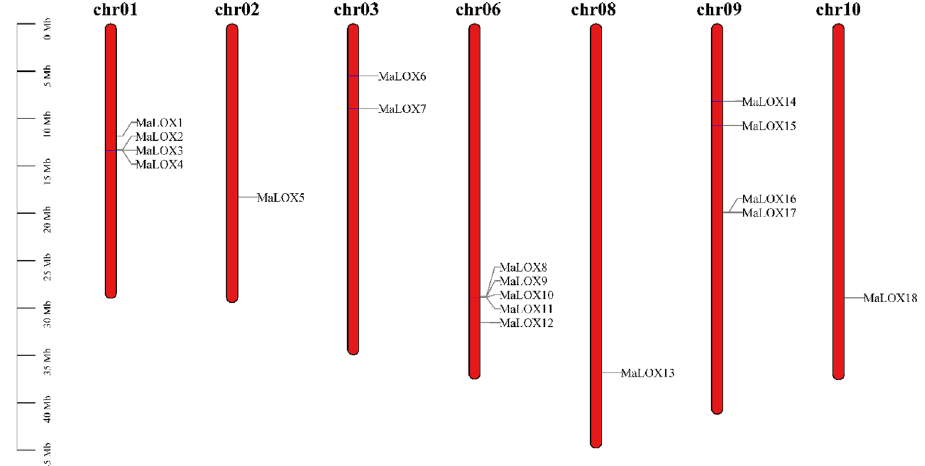
Figure 4. Chromosome localization of MaLOX